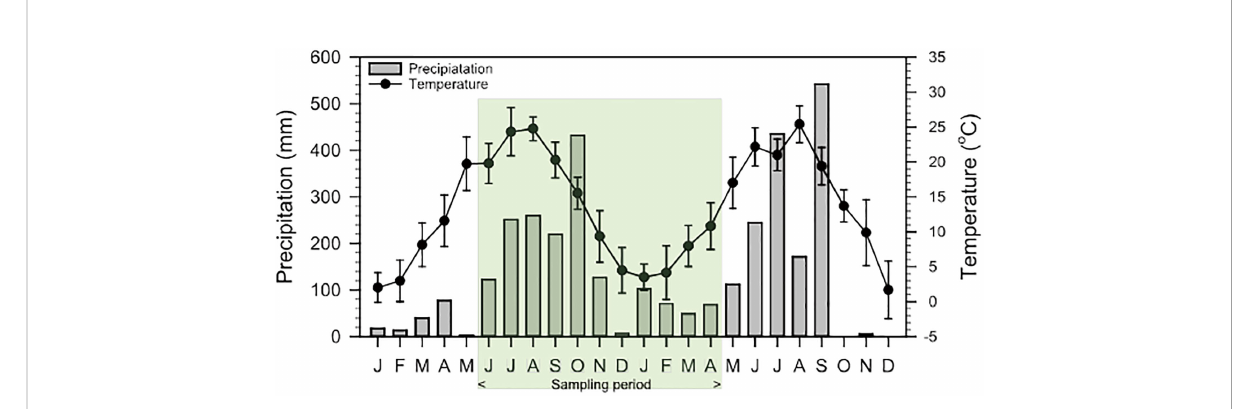
FIGURE 2 Monthly precipitation and average of atmospheric temperature variations from January 2019 to December 2020 in Gangneung city. Green box represents sampling